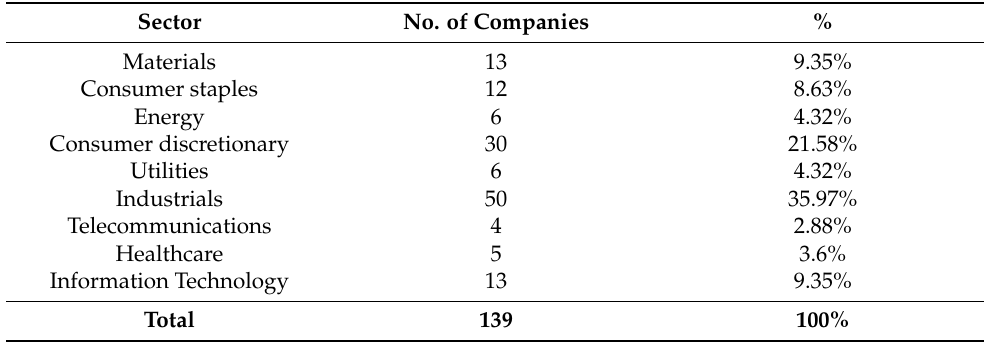
Table 1. Sample Sector